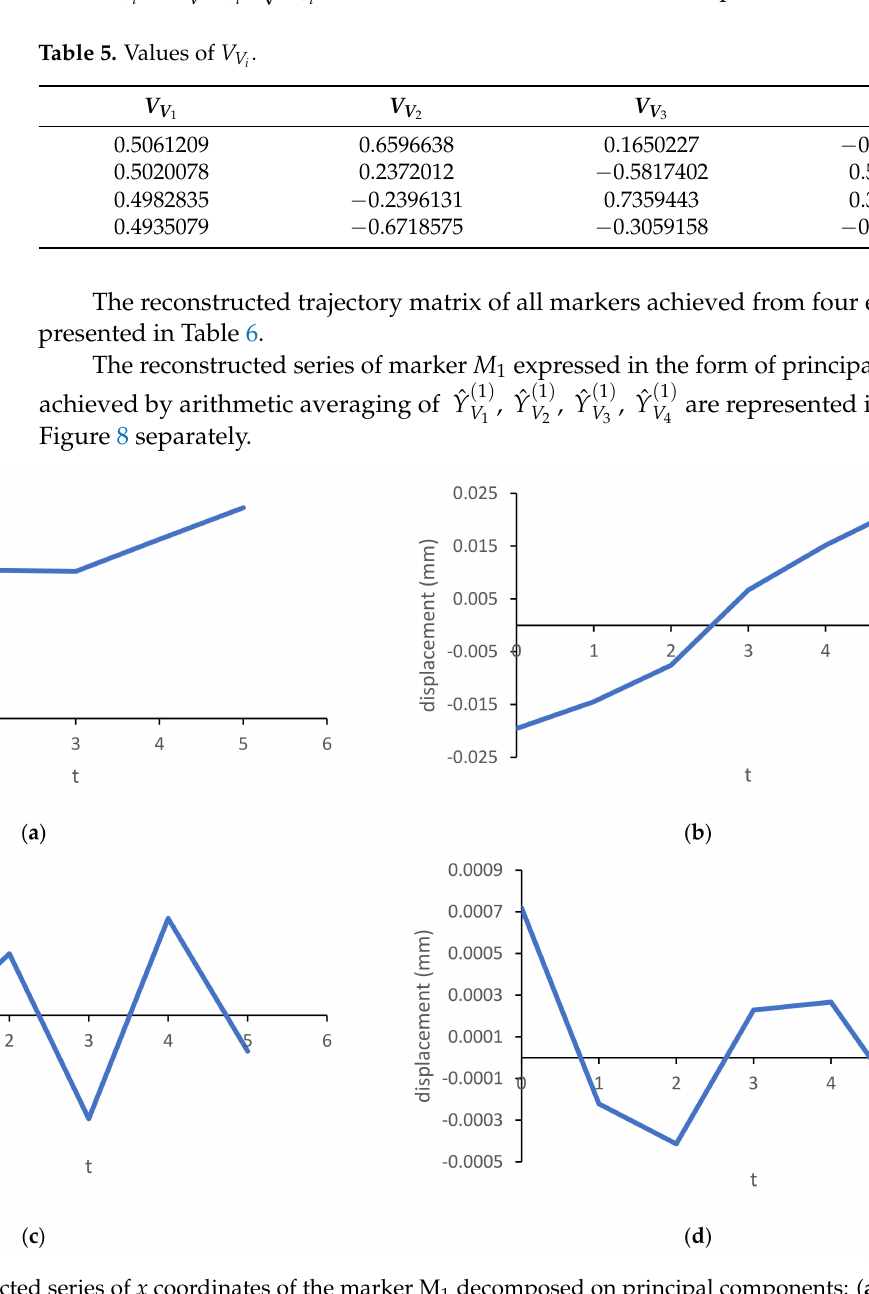
Table 5. Values of V V